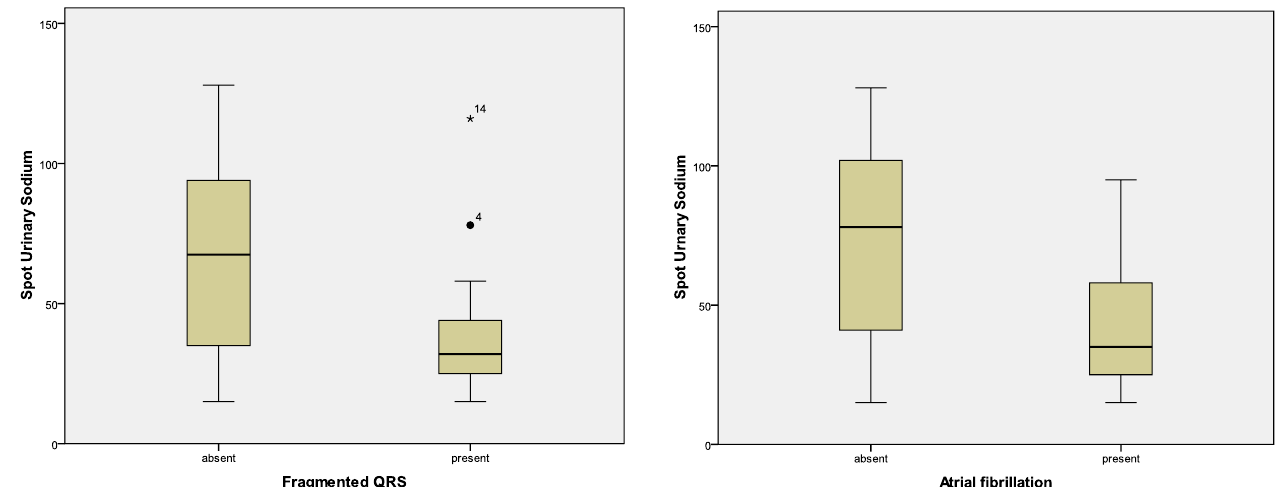
Figure 3. Correlations of spot urinary sodium with fragmented QRS and atrial fibrillation in patients with AHF.